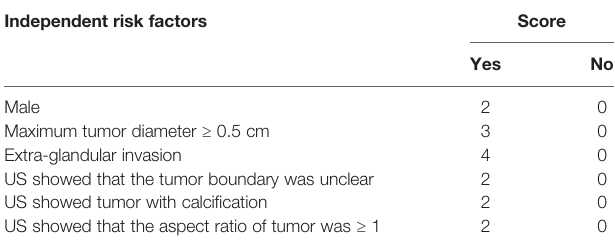
TABLE 3 | Assignment of independent risk factors. Independent risk factors